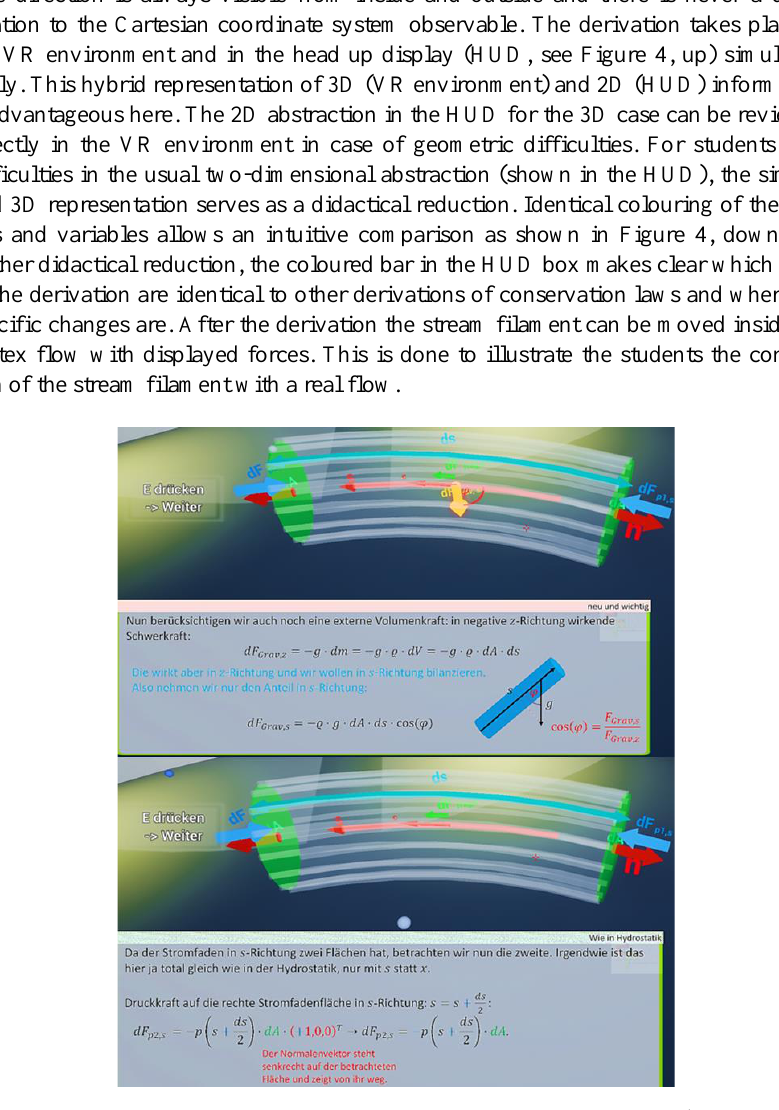
Fig. 4. Up: Hybrid representation of the derivation of a stream filament: 2D (HUD, box at bottom) and 3D in the VR engine. Down: Identical colouring of areas (green) and normal vectors (red) in HUD and VR speed up understanding. Green bar in box